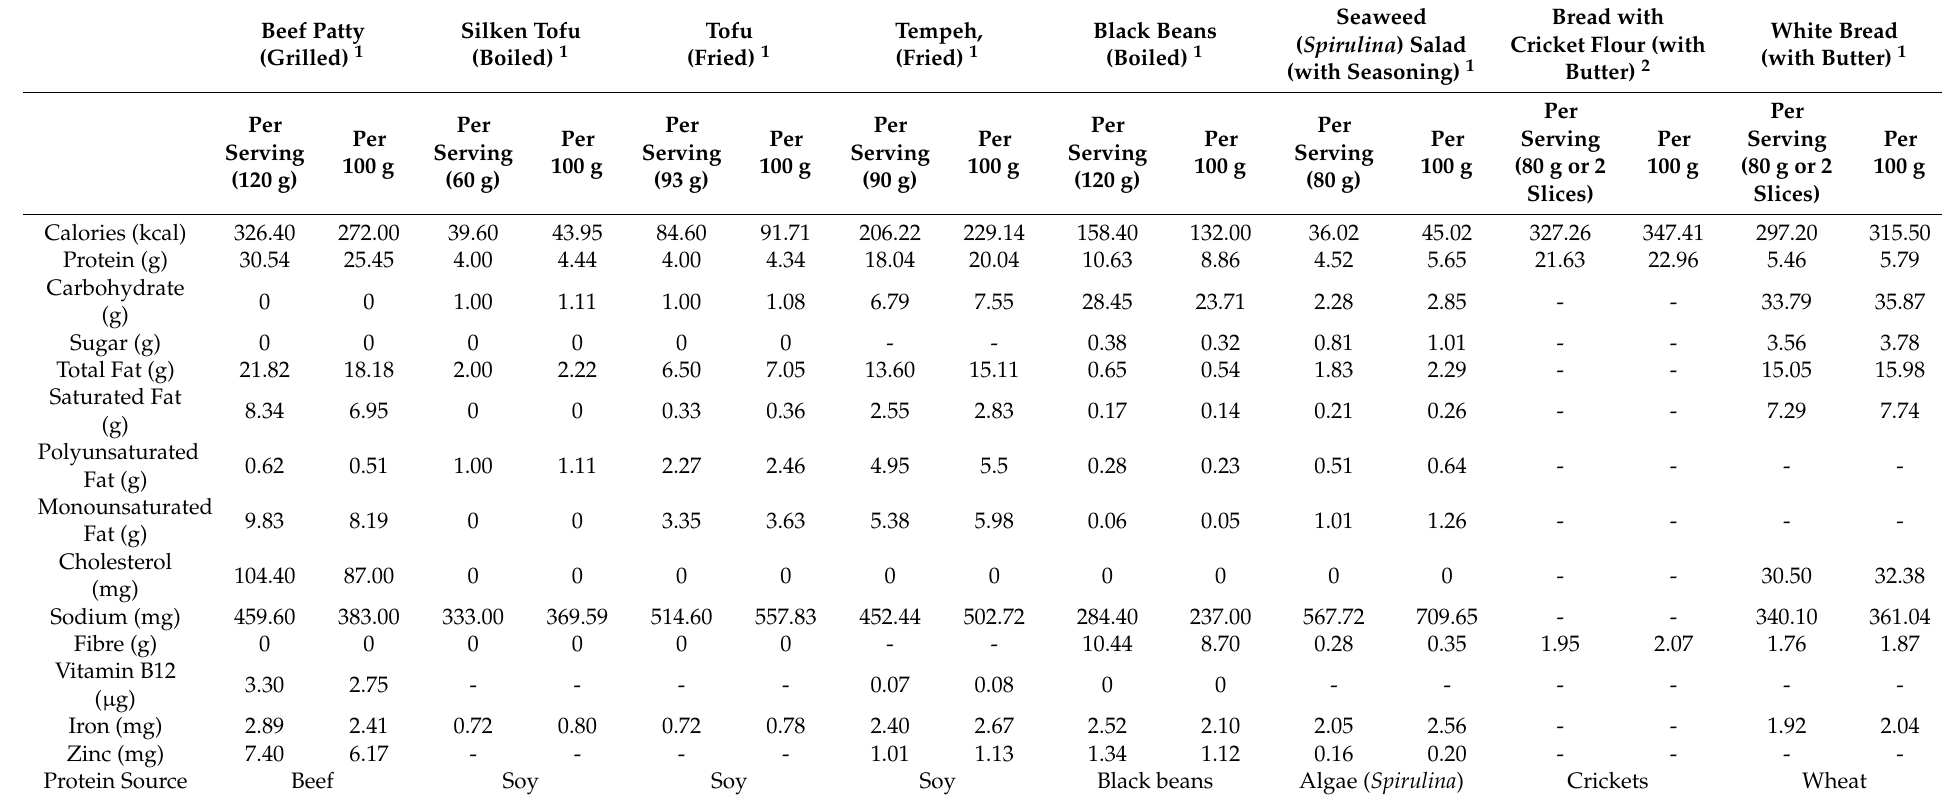
Table 4. Comparison of beef and alternative proteins (legumes, algae, and insects), as prepared and